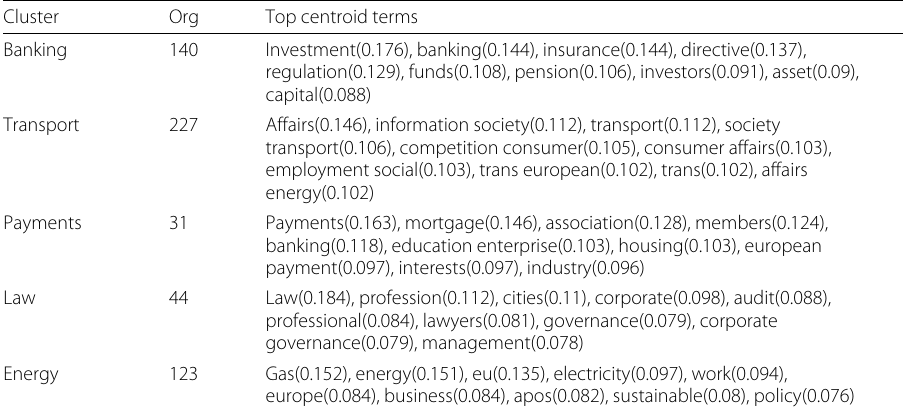
Table 7 Results of clustering ( K = 5) applied to textual self-descriptions of organizations